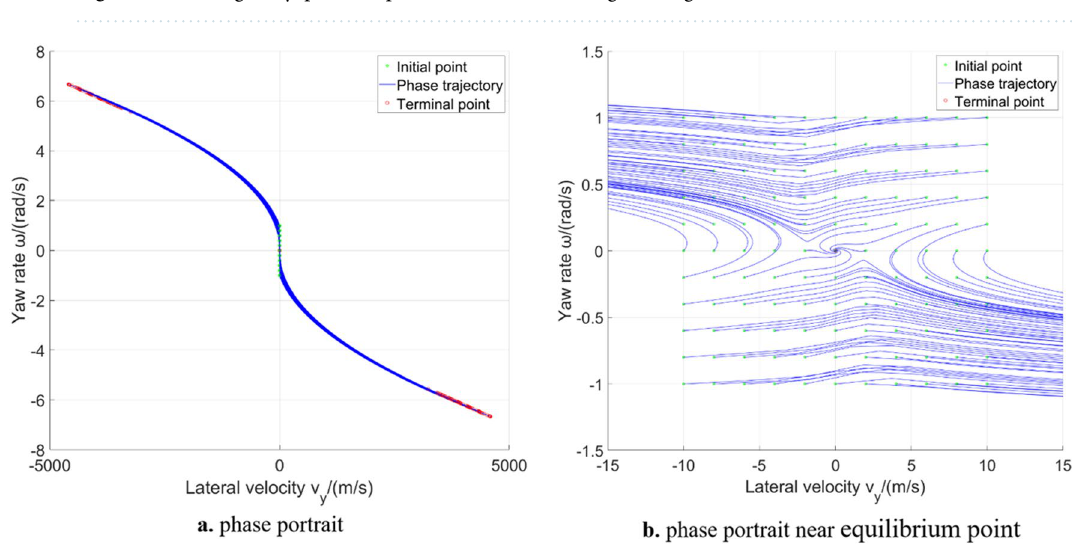
Figure 6. Phase portrait of 2-DOF vehicle